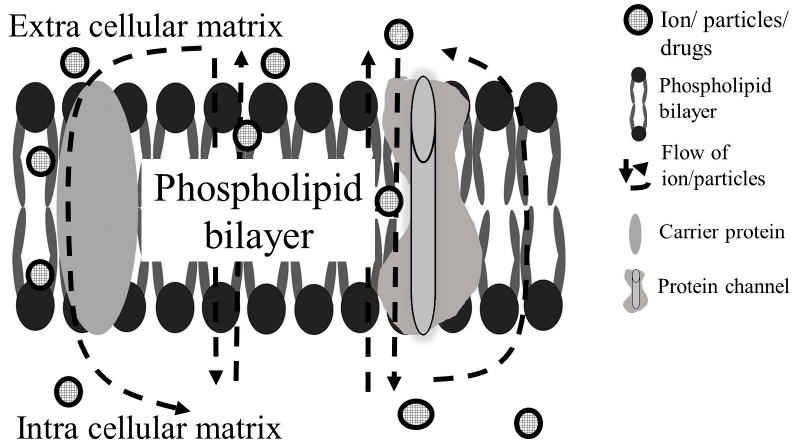
Figure 3. Plasma membrane with the ion/particle flow into and out of the cells. Certain ion/particles can simply pass through the plasma membrane by diffusion, while others need to pass through the protein channel or carrier protein.